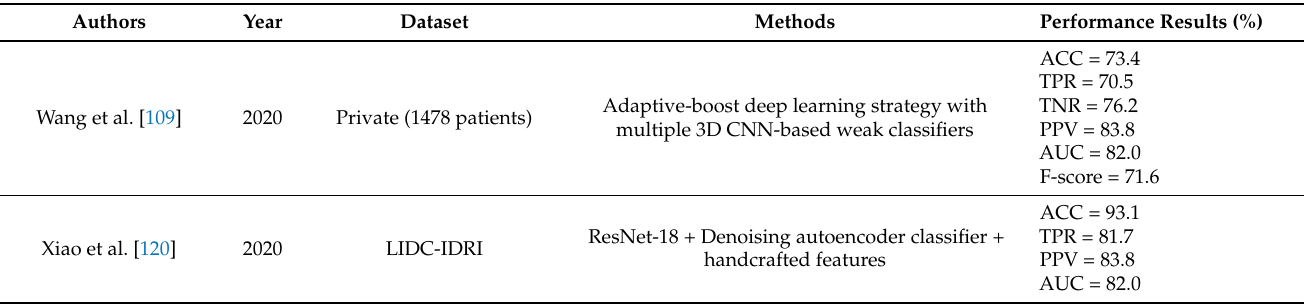
Table 3. Overview of published works regarding nodule classification approaches in lung CT images